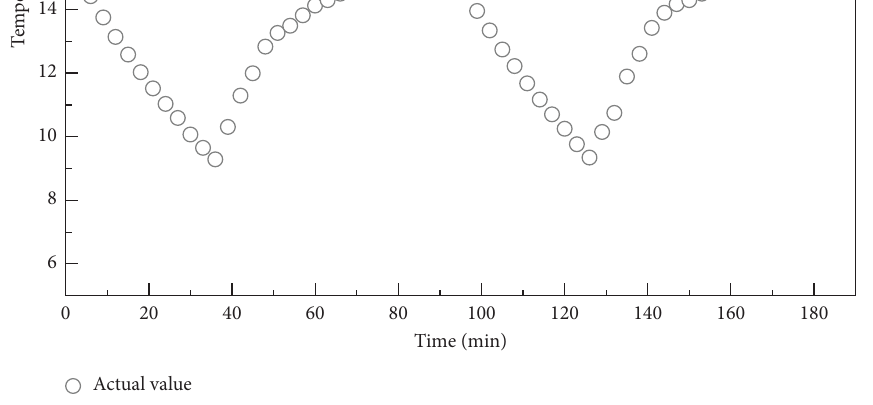
Figure 3: Measured SR temperature.